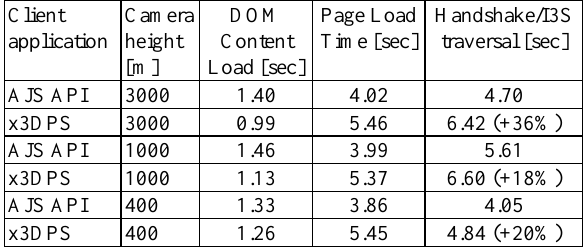
Table 15. Performance comparison between ArcGIS JavaScript API (abbreviated to AJS API) and extended 3D